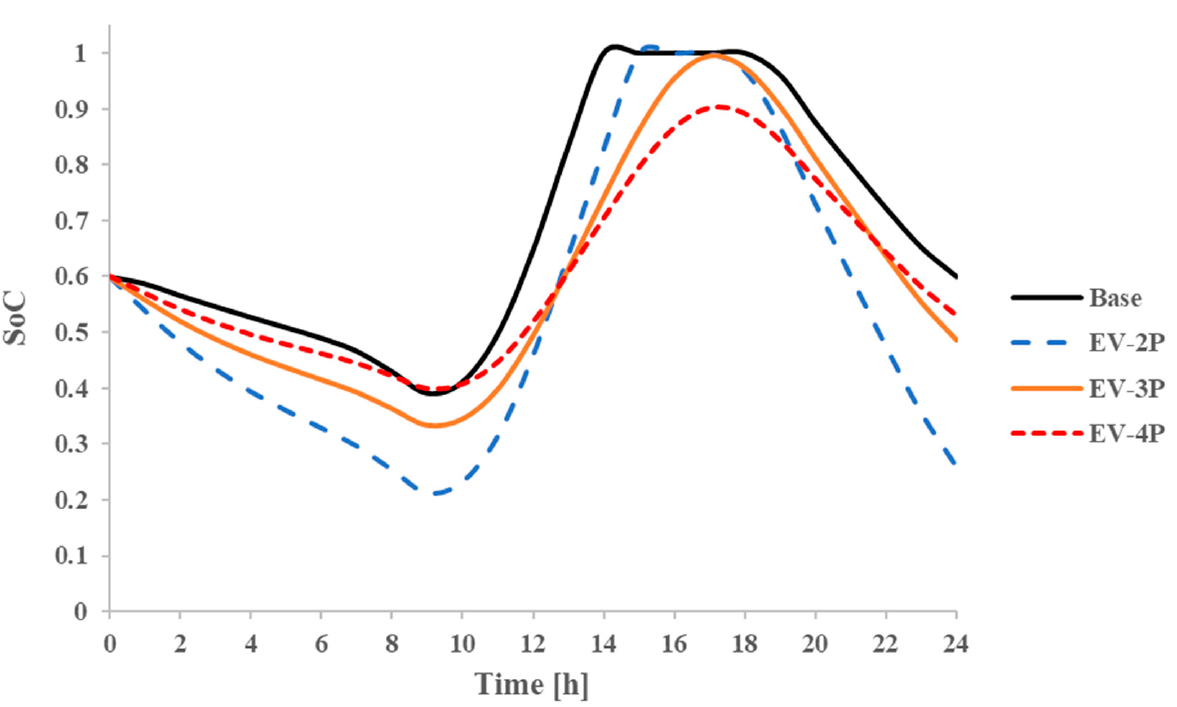
Figure 14. Second life battery SoC for different scenarios in various times during the day.